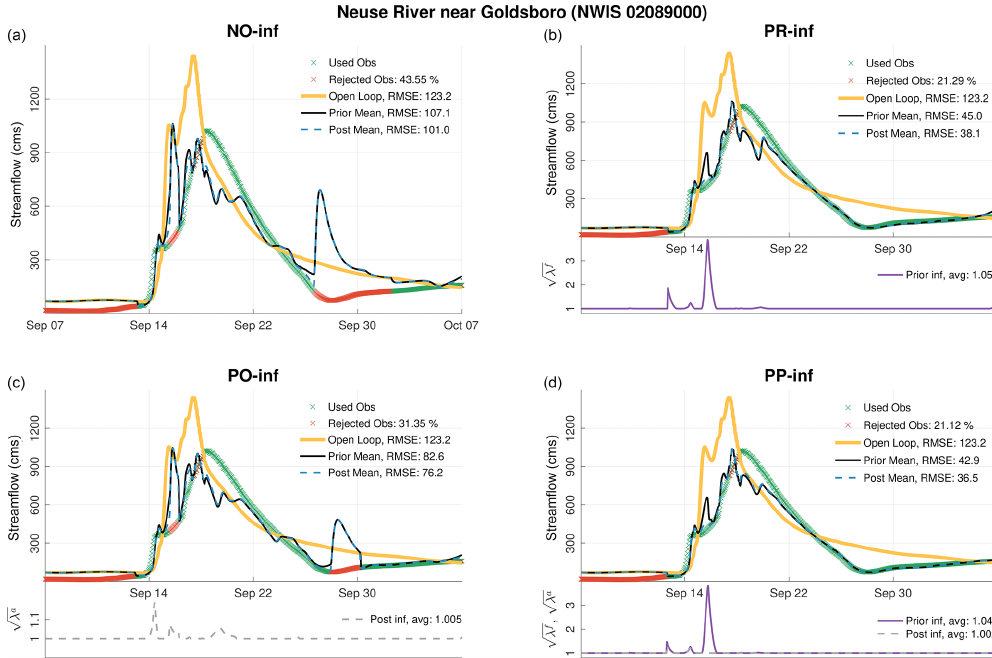
Figure 8. Similar to Fig. 7 but for the downstream Neuse River near Goldsboro